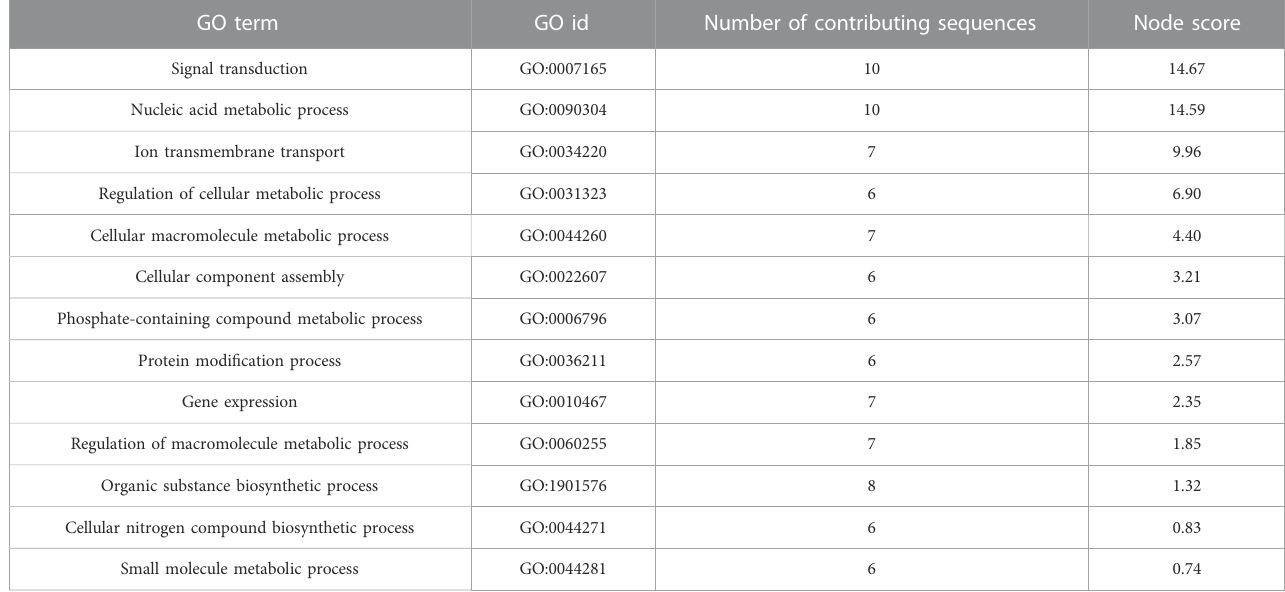
TABLE 2 Upregulated biological process child gene ontology terms for transcripts that were differentially expressed in families 84 and 89 DESeq2 comparisons. GO